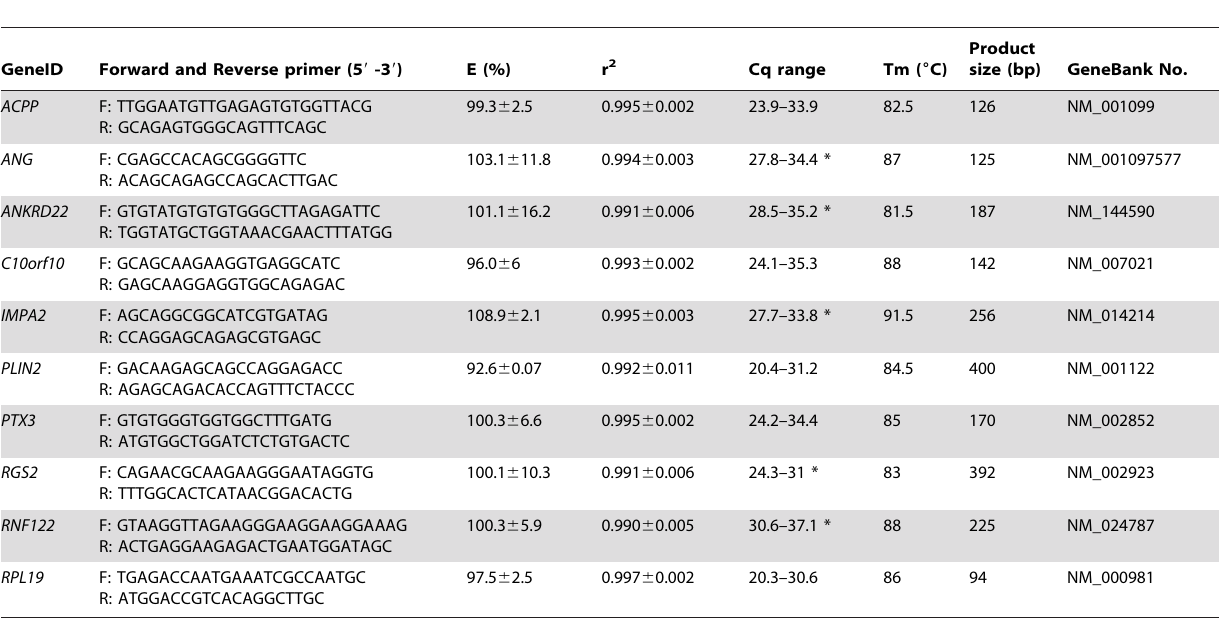
Table 2. qPCR primer sequences, PCR efficiency, correlation coefficient of standard curves, Cq range of standard curves, amplicon size and melting